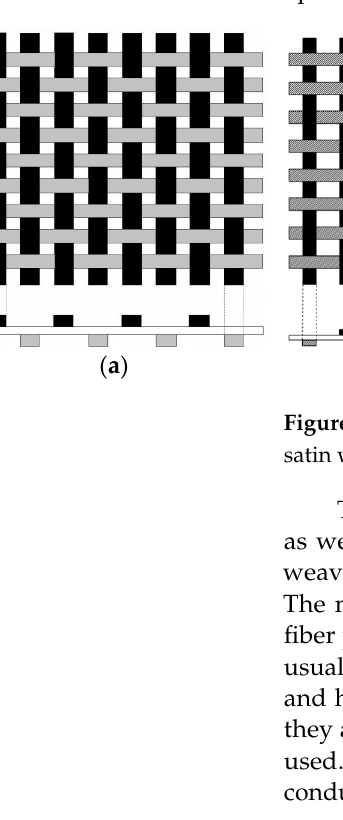
Figure 9. Glass fiber applications in various sectors.